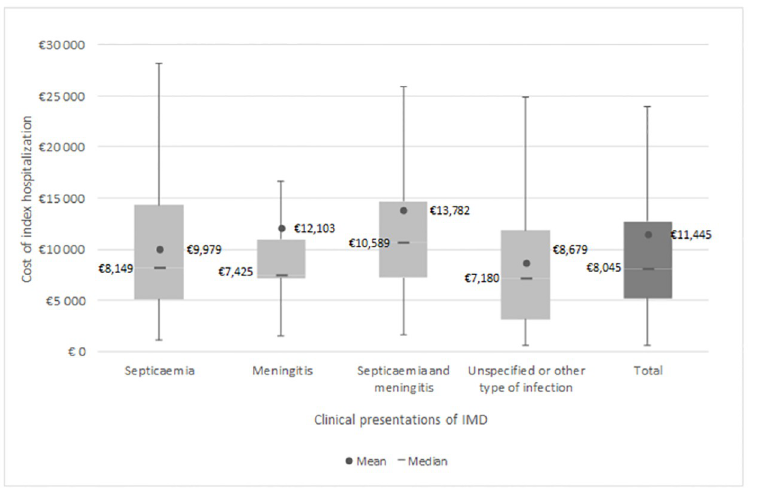
Fig 2. Cost of the index